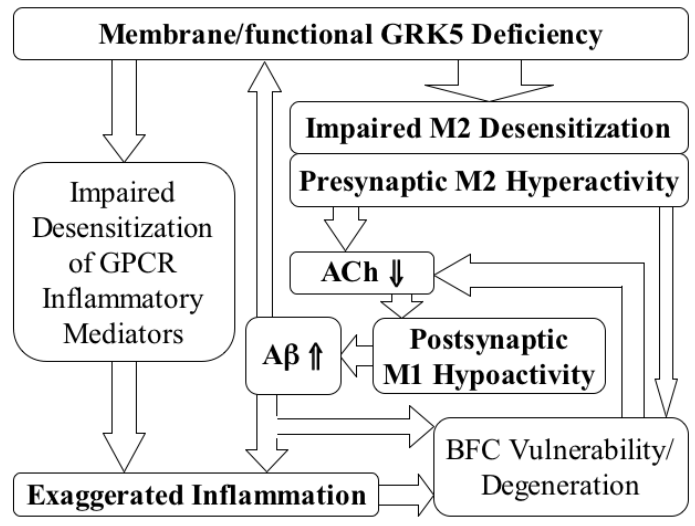
FIGURE 2. Schematic illustration of potential pathogenic impact of GRK5 deficiency. The schema is self-explanatory. BFC stands for basal forebrain